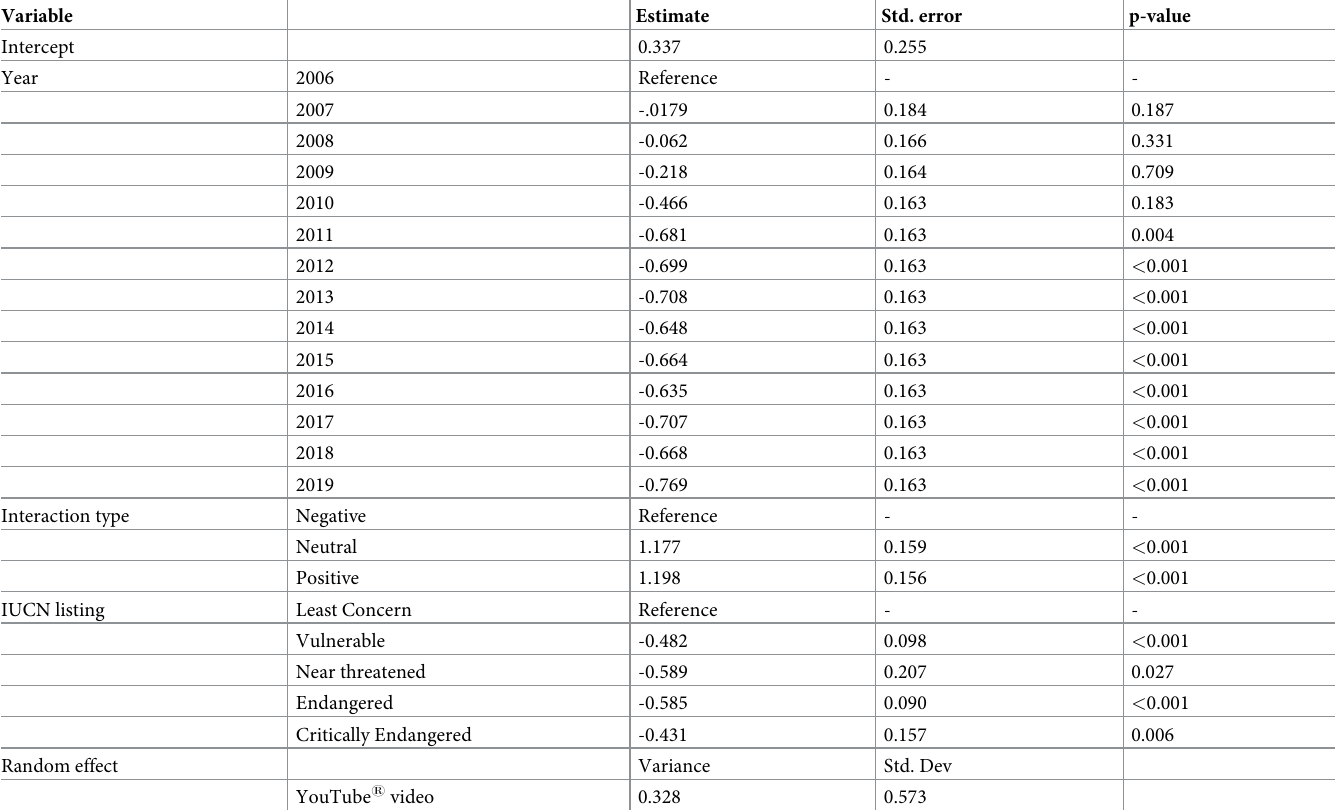
Only English comments are included.